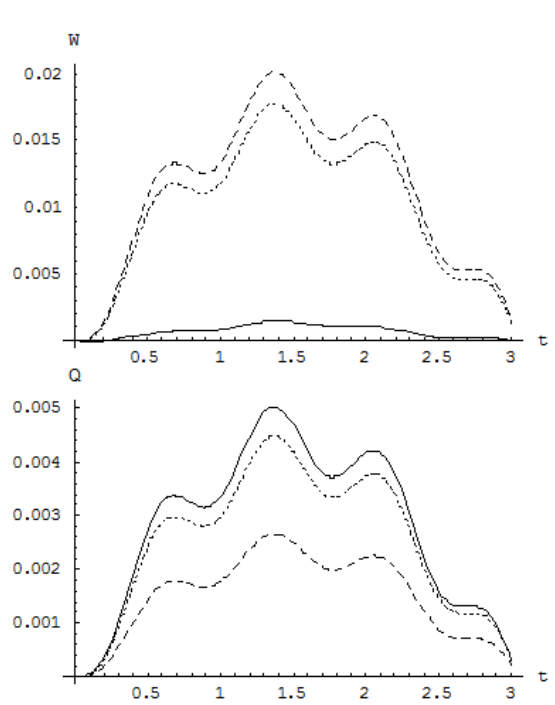
Figure 13: The influence of the eccentricity for υ = 30 m/s, R = 50 m, and ___ e H = 3 m, ...... e H = 0 m, - - - e H = −3 m.